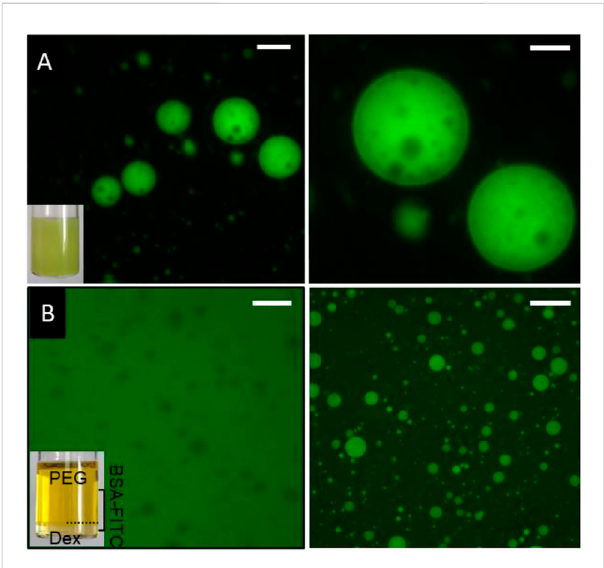
FIGURE 2 Panel (A) solvent shifting applied to ATPS-containing Dex- FITC. Sample tube photo (left) shows homogeneous stable emulsion and epi fl uorescence microscopy (left: scale bar is for 20 µm and right for 10 µm) allows visualizing FITC labelled Dex only, con fi rming the presence of small PEG droplets lacking fl uorescence within main droplets. Panel (B) solvent shifting applied to ATPS-containing BSA- FITC. Sample tube photo (left) after macroscopic phase separation in the solvent-free sample allowing visualizing the presence of protein preferentially in the PEG phase (not quantitatively). This is con fi rmed byepi fl uorescencemicroscopyshowinghigher fl uorescenceintensity out of droplets (left, black patches, scale bar is for 50 µm). Epi fl uorescence image of a sample after solvent shifting (right) showing that fl uorescent proteins were fully incorporated within stable Dex-rich droplets (the scale bar is for 50